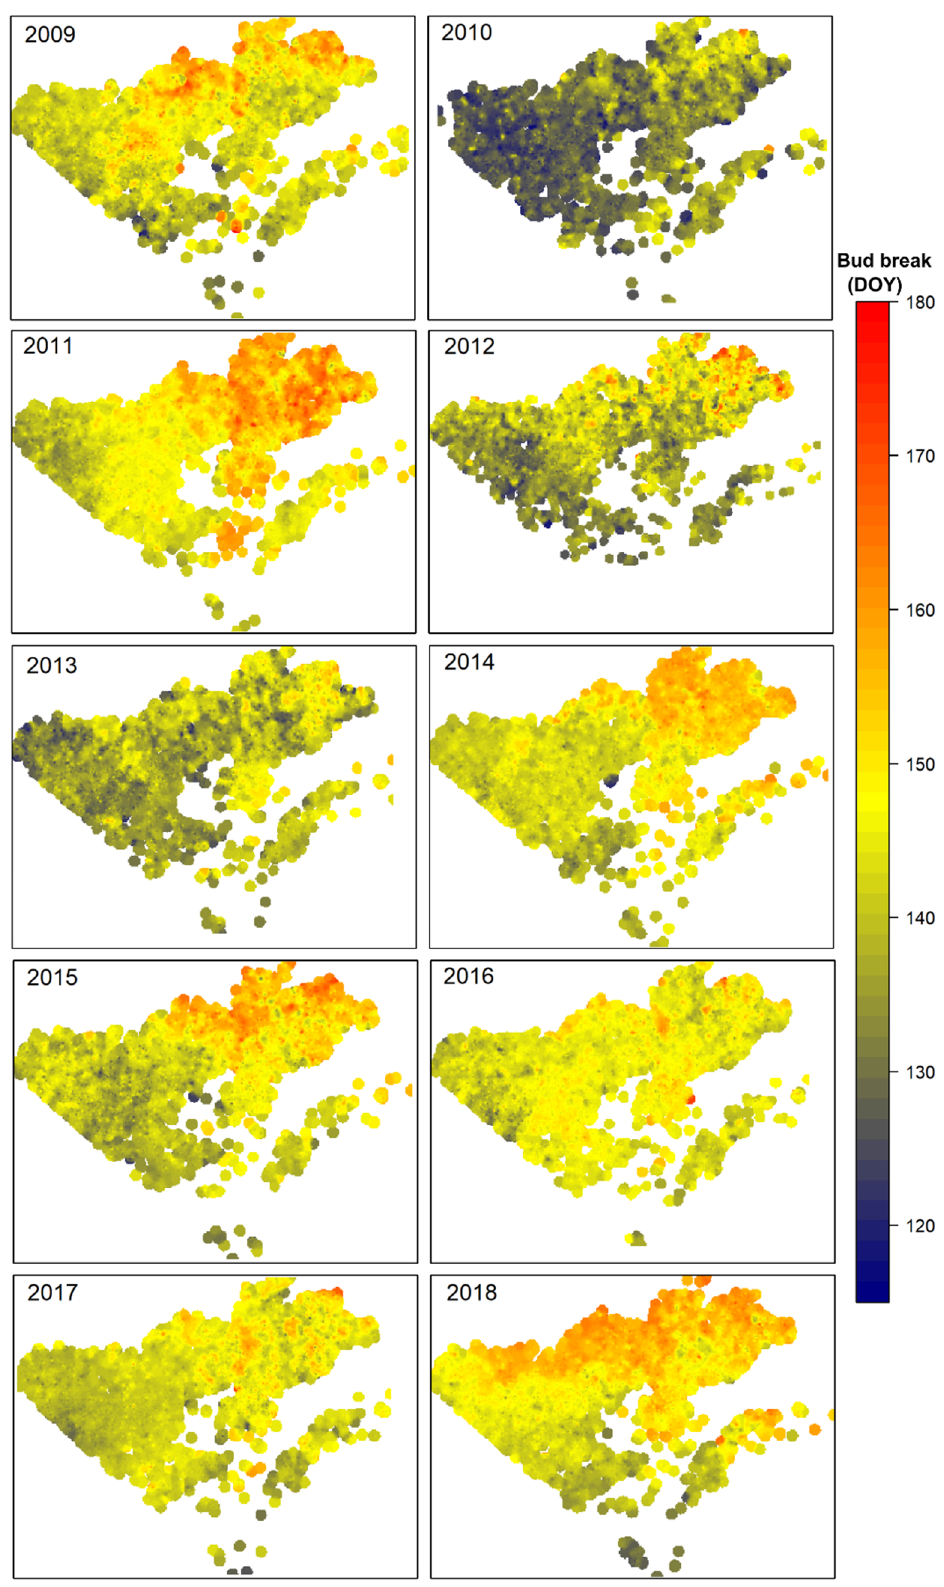
Figure 6. Hotspot analysis of bud break (phase B1) dates (DOY) across boreal black spruce stands in the study area in Quebec, Canada.